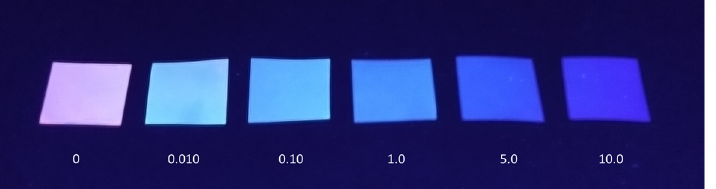
Figure 4. Photographs under 365 nm light of PBS strips after dipping in aqueous solution of different concentration of Cu 2+ (range 0–10.0 × 10 − 3 M).